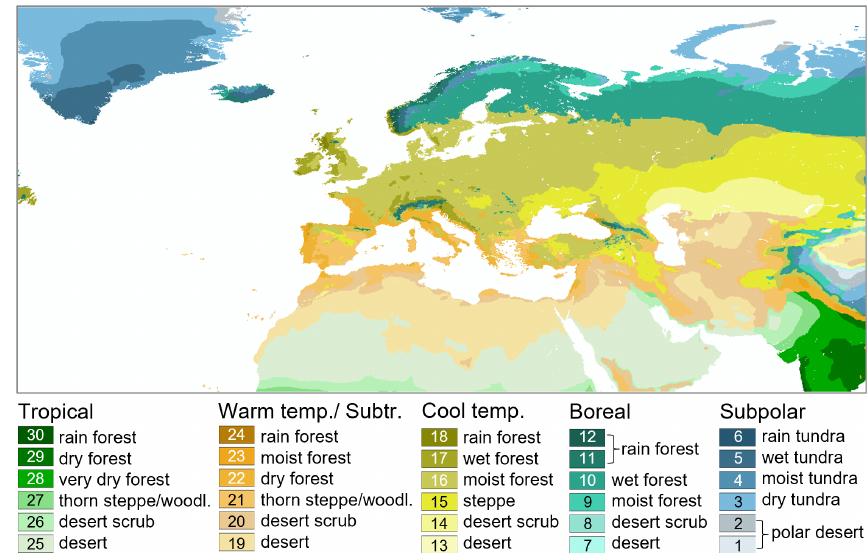
Figure 2. Holdridge life zone map for the extent of LANDMATE PFTs.